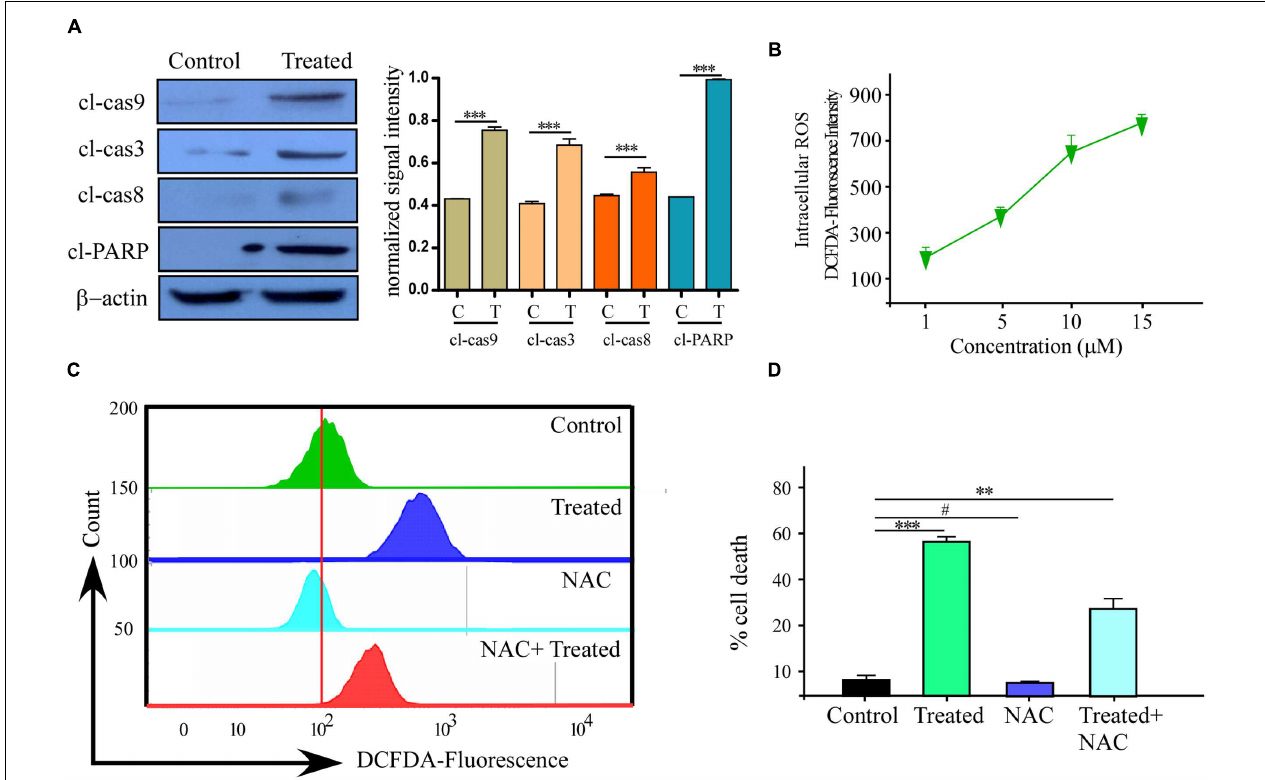
FIGURE 3 | Reactive oxygen species (ROS) production with Caspase activation is one of the reason of Phemindole mediated MDAMB-231 cells apoptosis. (A) Western blot analysis of cleaved caspase-3, cleaved caspase-9, cleaved caspase-8 and cleaved-PARP in control and Phemindole treated MDAMB-231 cells (Left panel). β -actin was used as loading control. Blots are representative of three independent experiments and quantifications are indicated by Bar diagram (Right panel). Values were normalized by intensity of positive control. (B) Line diagram representation of the dose dependent ROS production in MDAMB-231 cells on treatment with Phemindole. (C) Phemindole treated MDAMB-231 cells were assessed by flow cytometry for ROS generation by measuring the DCF-fluorescence intensity and the data was represented by histogram overlay. (D) Percentage of cell death from Phemindole induced with/without NAC